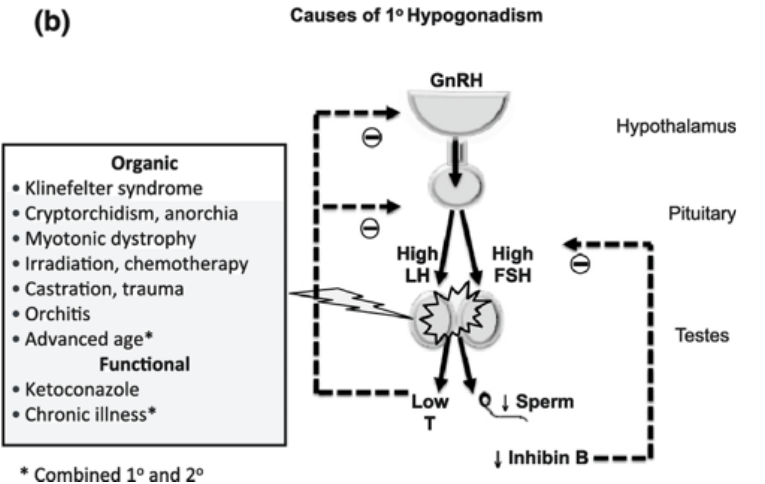
Figure 1. Classified causes of hypogonadism by Grossmann and Matsumoto via PMC Open Access Subset [16]. * is noted to be “combined primary and secondary hypogonadism”.